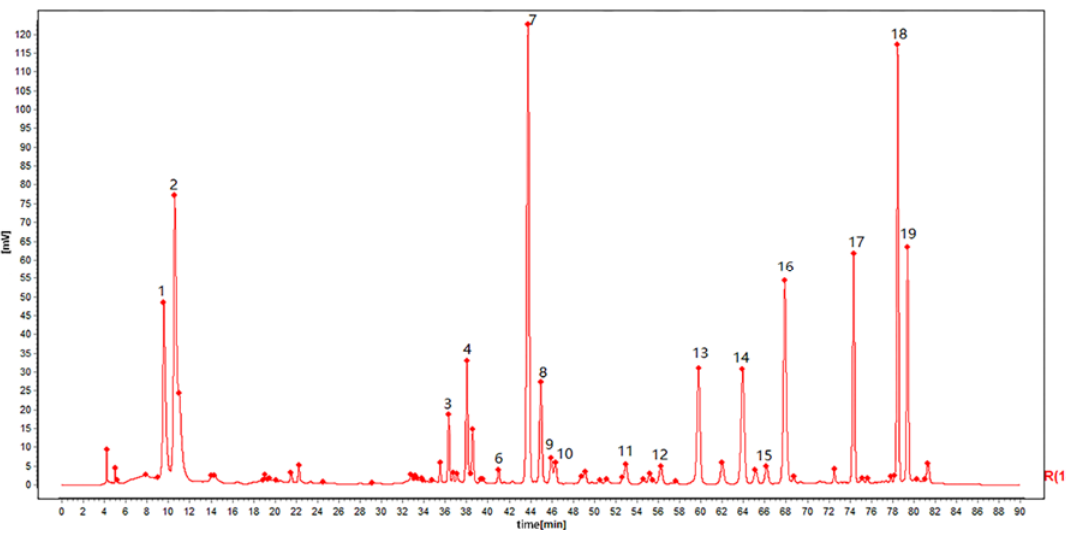
Figure 1. HPLC fingerprints of the 21 batches of toad venom extracts.